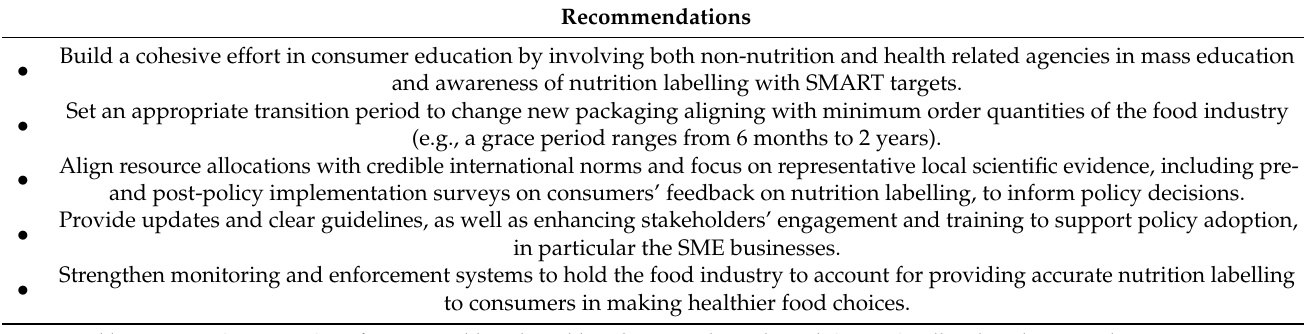
Table 2. Recommendations for stakeholders to progress future food labelling policy processes.